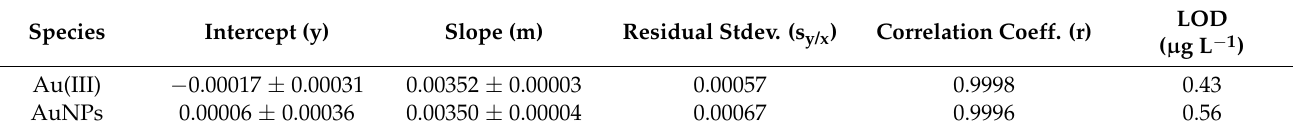
Table 2. Characteristics of the calibration curves over the range 0–20 µ g L − 1 . Species Intercept (y) Slope (m) Residual Stdev. (s y/x ) Correlation Coeff. (r)